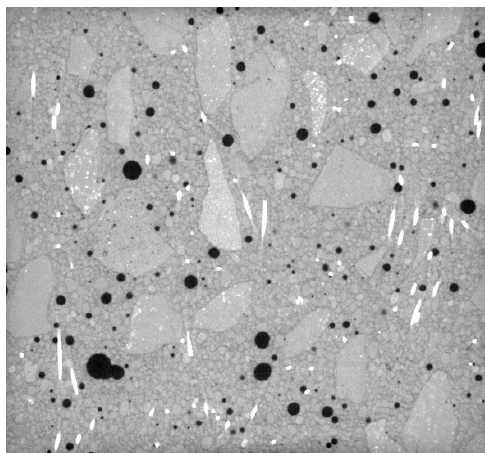
Figure 3. Example of one 2D slice.